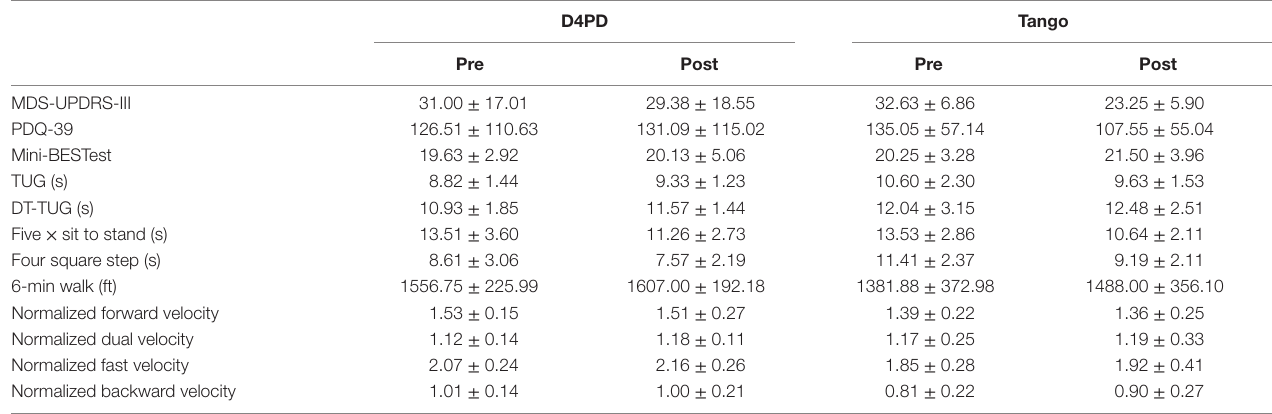
Values are M ± SD. Gait velocities (centimeter per second) are normalized to participants’ leg lengths